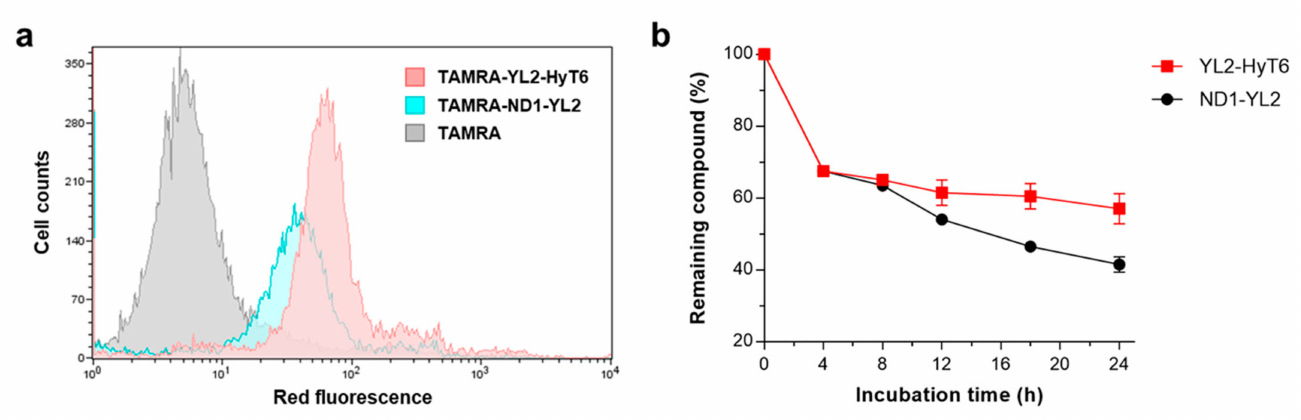
Figure 5. ( a ) Flow cytometry analysis of cellular uptake efficiency of TAMRA-YL2-HyT6 and TAMRA-ND1-YL2 in MDA- MB-231 cells. MDA-MB-231 cells were incubated with 10 µ M compounds for 4 h at 37 ◦ C. ( b ) Serum stabilities of YL2-HyT6 and ND1-YL2.